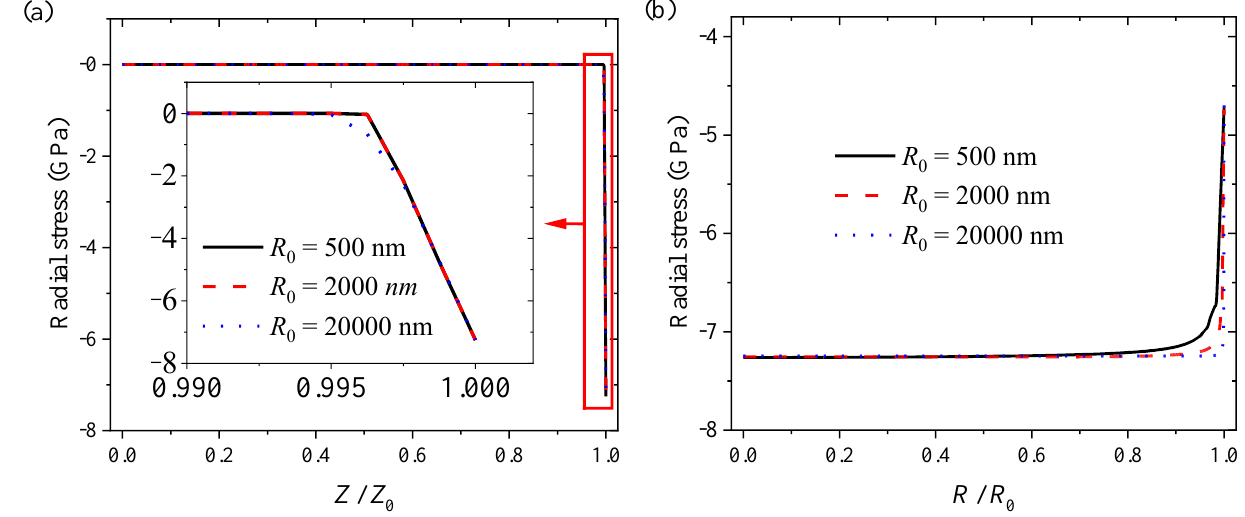
Figure A1. Variations in the radial stress along ( a ) the film thickness at axisymmetric axis and ( b ) the radial direction on the top surface at end of stage 0. Results of the disk with different initial radii of 500, 2000 and 200,000 nm are depicted. The numerical results show that there are no observable differences between the corresponding stresses in the region far away from the disk edge. Here, Z = 0 corresponds to the interface between the a-Si and the current collector and Z = Z 0 corresponds to the interface between the a-silicon electrode and electrolyte.